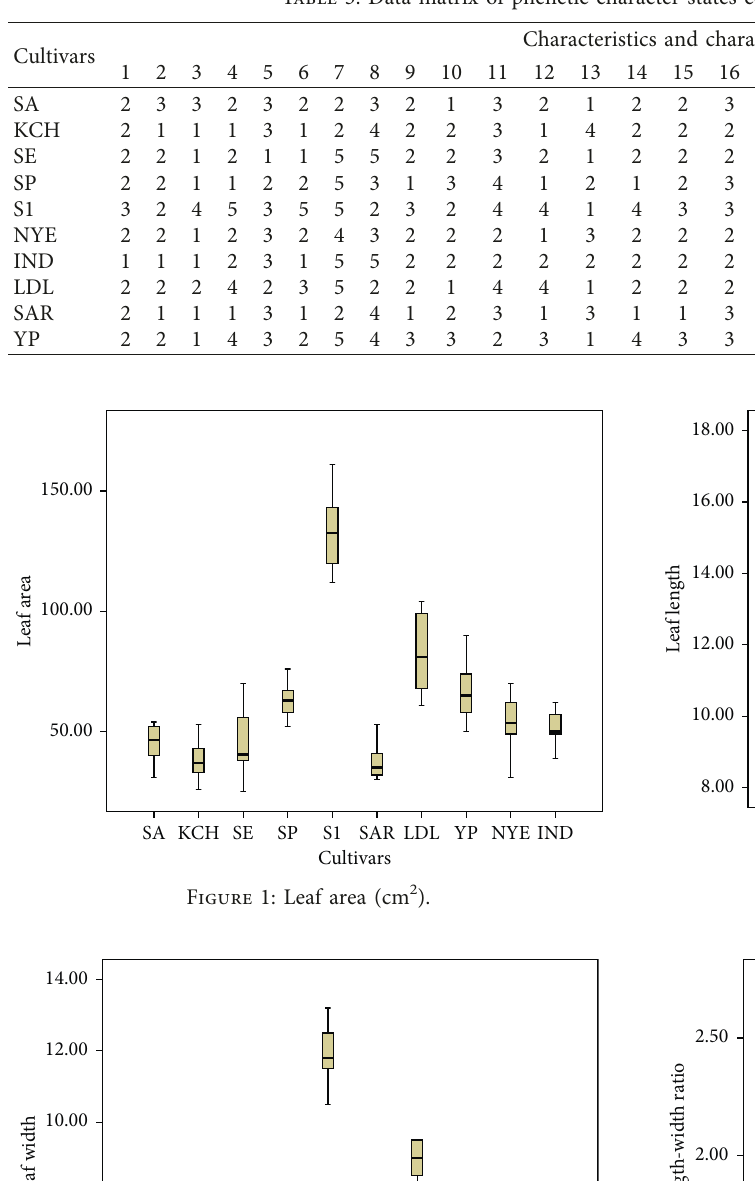
Figure 1: Leaf area (cm 2 ).